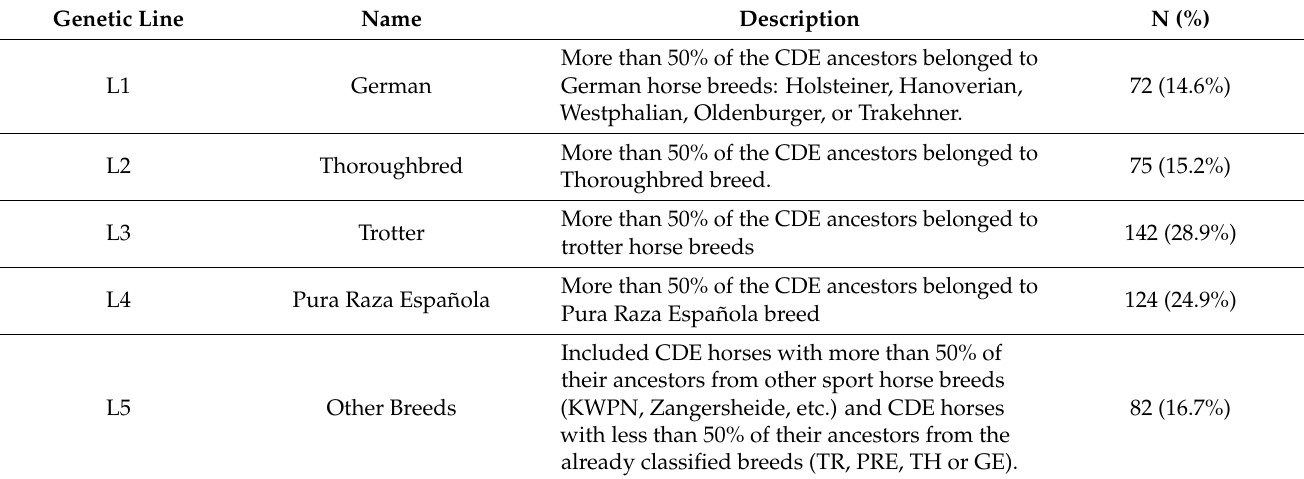
Table 1. Description of the Spanish Sport Horse (CDE) genetic